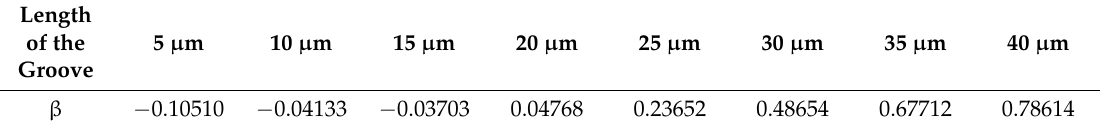
Table 3. Plate parameter β varying with the length of the square groove for 70 µ m DFUT.